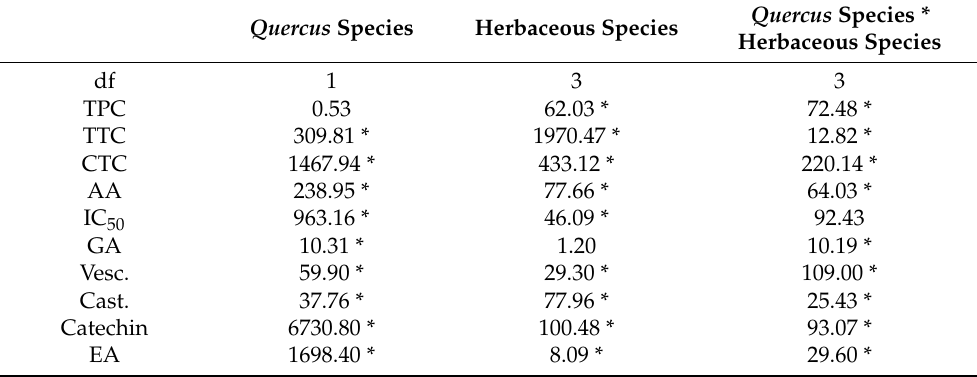
Table 2. Effect of Quercus species ( Q. faginea and Q. suber ), herbaceous species ( D. tenuifolia, E. vesicaria and L. luteus ) and their interactions on Quercus chemical defences (total phenols TPC, total tannins TTC and condensed tannins CTC), antioxidant activity (AA and IC 50 ) and the major low molecular weight compounds in phenolic extracts (gallic acid GA, vescalagine Vesc., castalagine Cast., Catechin and ellagic acid